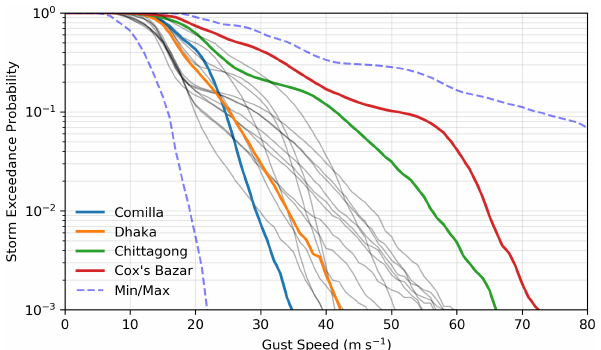
Figure 5. Exceedance probability curves for 18 of the most pop- ulated towns and cities in Bangladesh (grey lines), with four key cities highlighted: Dhaka (orange), Comilla (blue), Chit- tagong (green) and Cox’s Bazar (red). For reference, the mini- mum and maximum range of exceedance probabilities (across all of Bangladesh) are represented by the dashed lines. Note that storm exceedance probability is shown on a log scale.